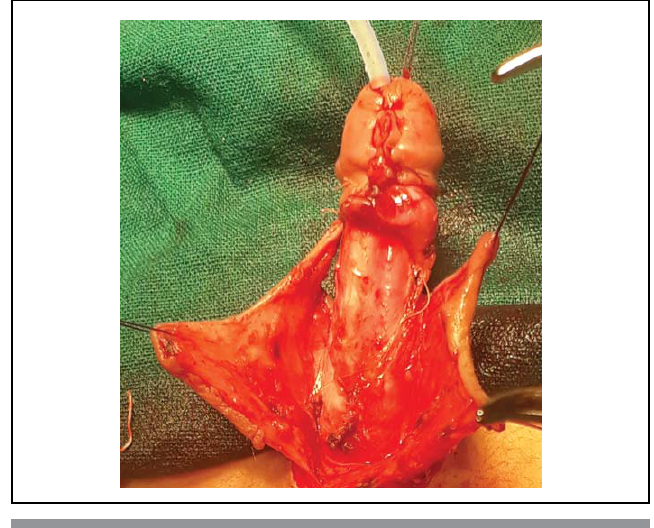
Figure 4. Scrotal flaps to cover penile